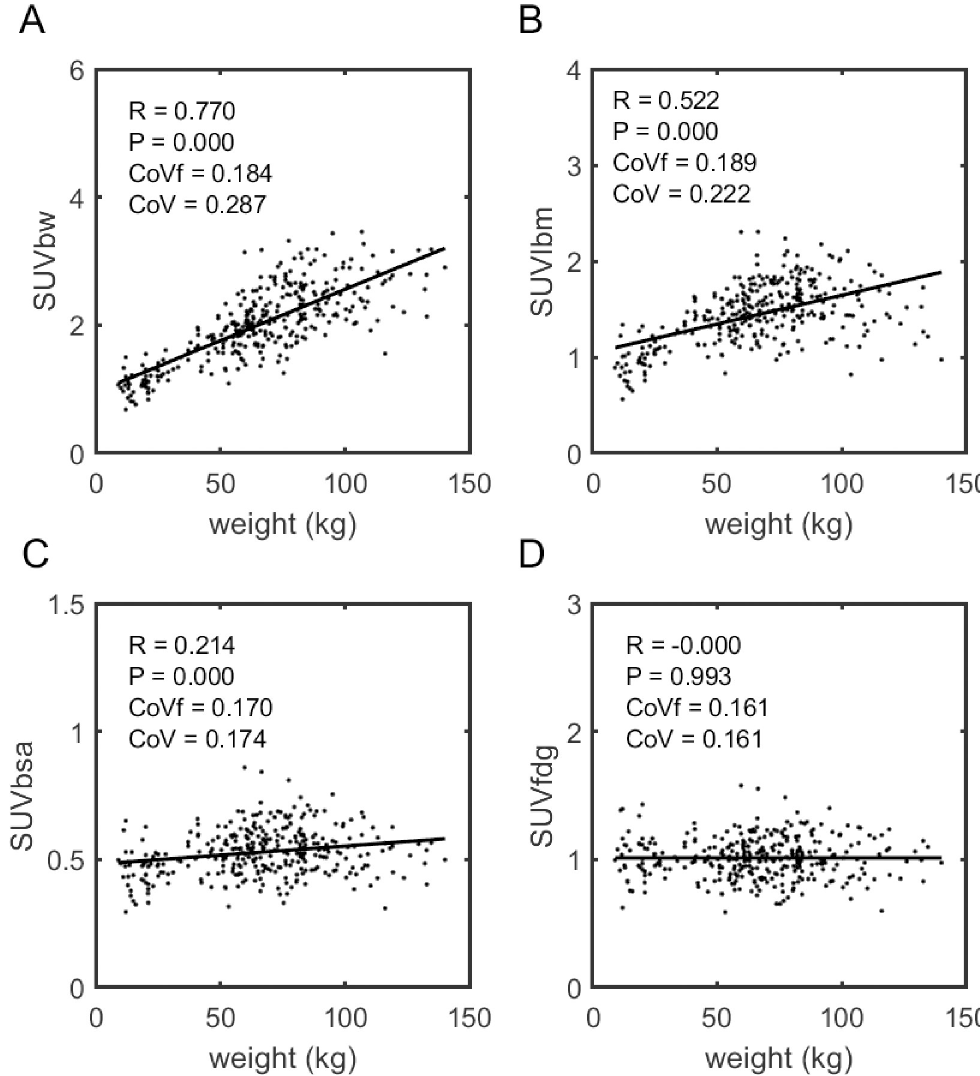
Fig 2. Training data, SUVs as a function of weight. Scatter plots showing the correlation of various types of liver SUV measurement to patient weight within the training cohort, (A) SUV bw , (B) SUV lbm , (C) SUV bsa and (D) the proposed SUV fdg metric. Only SUV fdg shows no significant correlation to weight. The CoVf value describes the variance about the fitted line while CoV describes the variance about the mean. mass and body-surface area, is based on simple measures (height and weight) of the patient that can be determined prior to imaging. Like SUV normalized by body weight, the SUV fdg metric calculated using the proposed normalizer can be considered unitless. The value can be interpreted as a fraction of the expected normal liver mean uptake at (approximately) 60 min- utes post injection wherein normal liver is expected to have a value of 1.0 and therefore any tis- sue with an SUV value of 2.0, for example, has twice the liver’s uptake. As such, this metric fdg can also be used as a quick quality assurance measure to identify data entry errors for the injected dose, its timing, or errors in the entry of the patient height or weight. Values dramati- cally different from 1.0 ± 0.16 measured in a normal region of a patient’s liver would be indica- tive of a problem, including perhaps significant extravasation of the injectate.